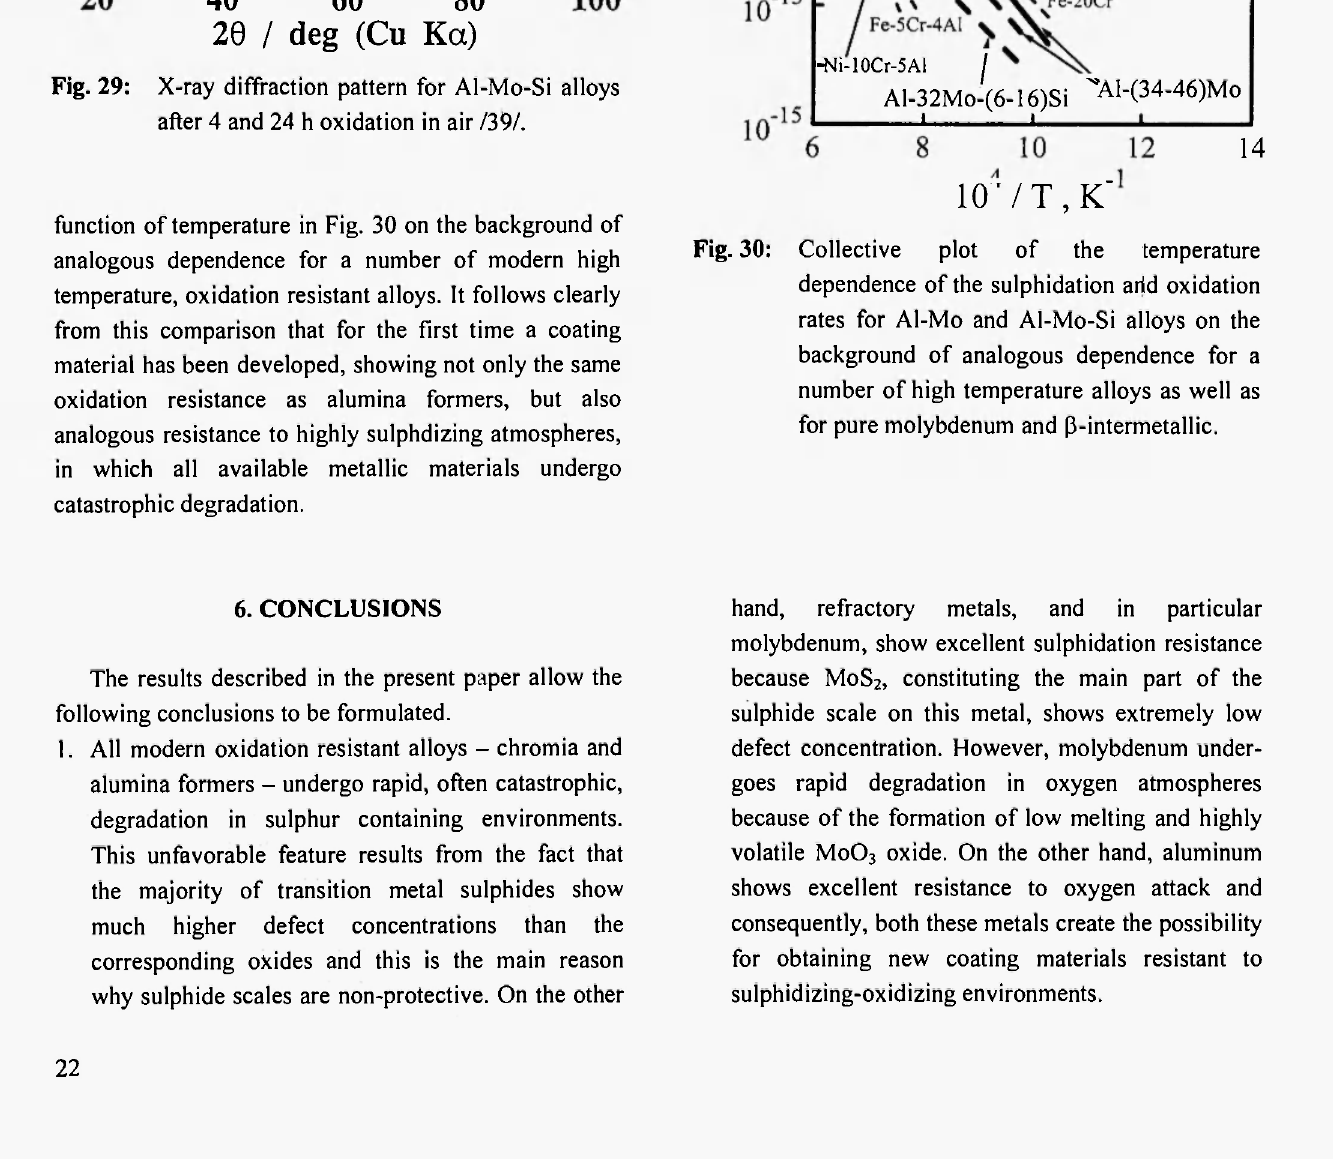
Fig. 29: X-ray diffraction pattern for Al-Mo-Si alloys after 4 and 24 h oxidation in air /39/.